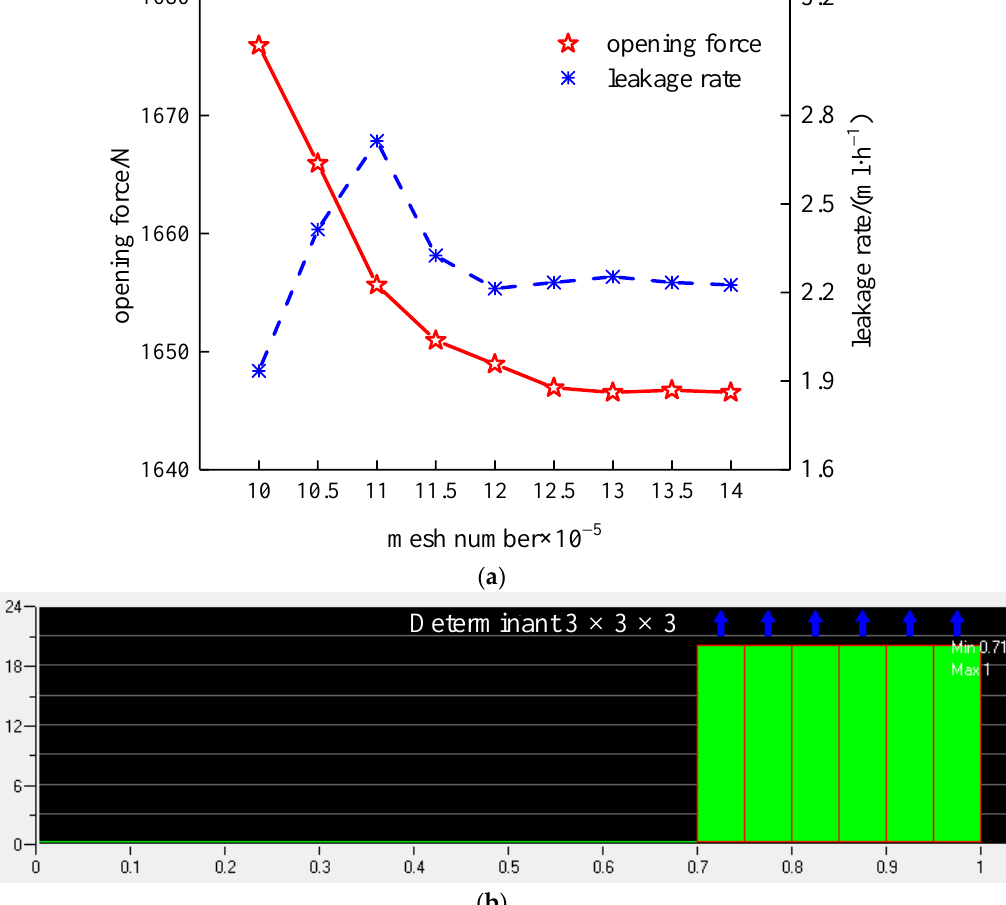
Figure 4. Meshing generation check: ( a ) grid independence verification; ( b ) mesh quality histo- gram.